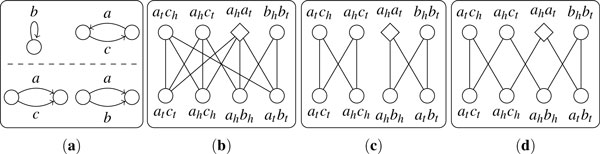
An example of adjacency graph with duplicate genes. (a) Structures of the two genomes. (b) Adjacency graph. (c) A decomposition with 2 cycles. (d) A decomposition with only 1 cycle. Diamonds and rectangles represent ghost adjacencies, and circles represent normal adjacencies.